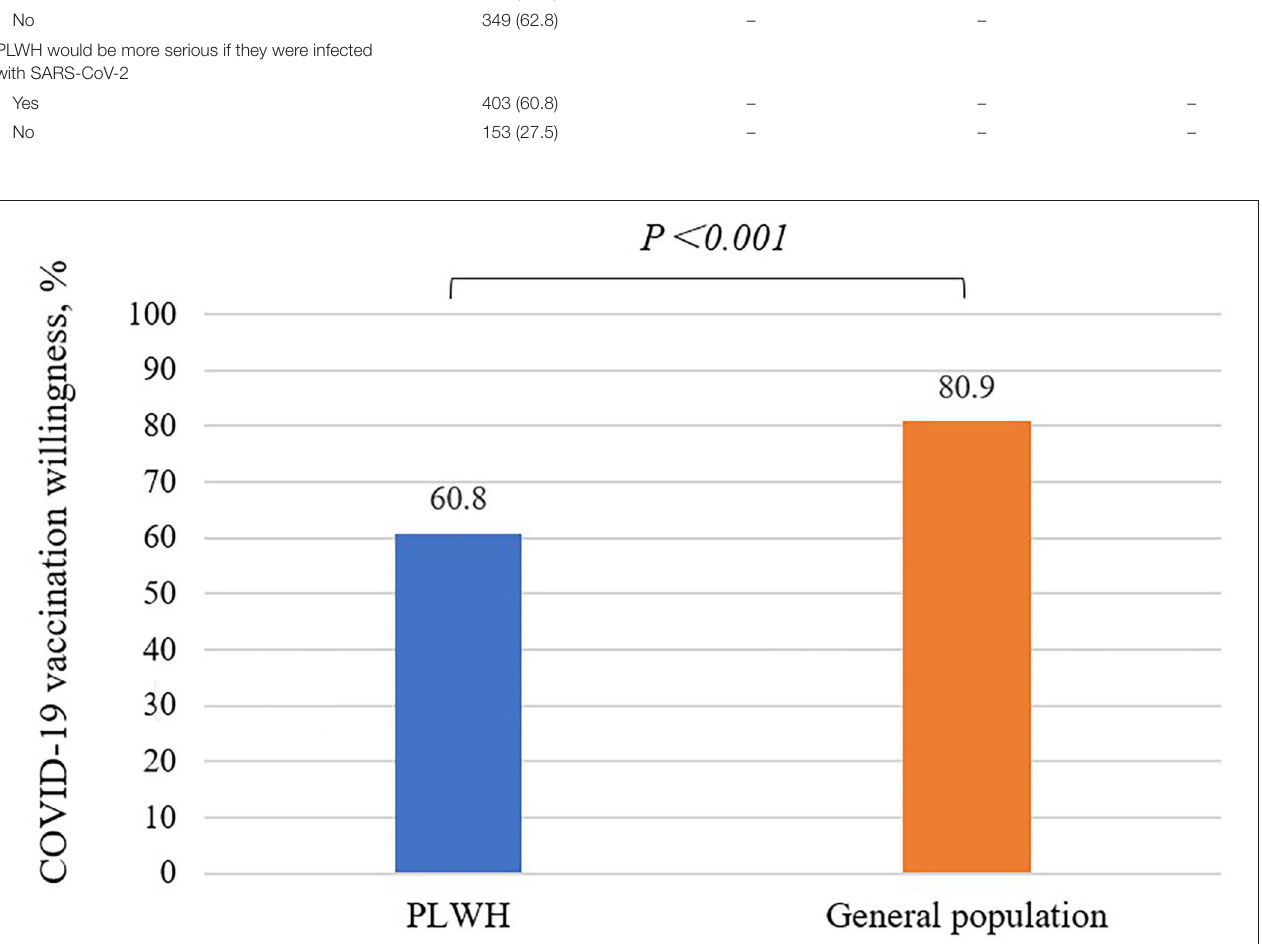
FIGURE 1 | COVID-19 vaccination willingness among PLWH (60.8%) is significantly lower than the general population (80.9%), P < 0.001, multivariable logistic regression model was used.